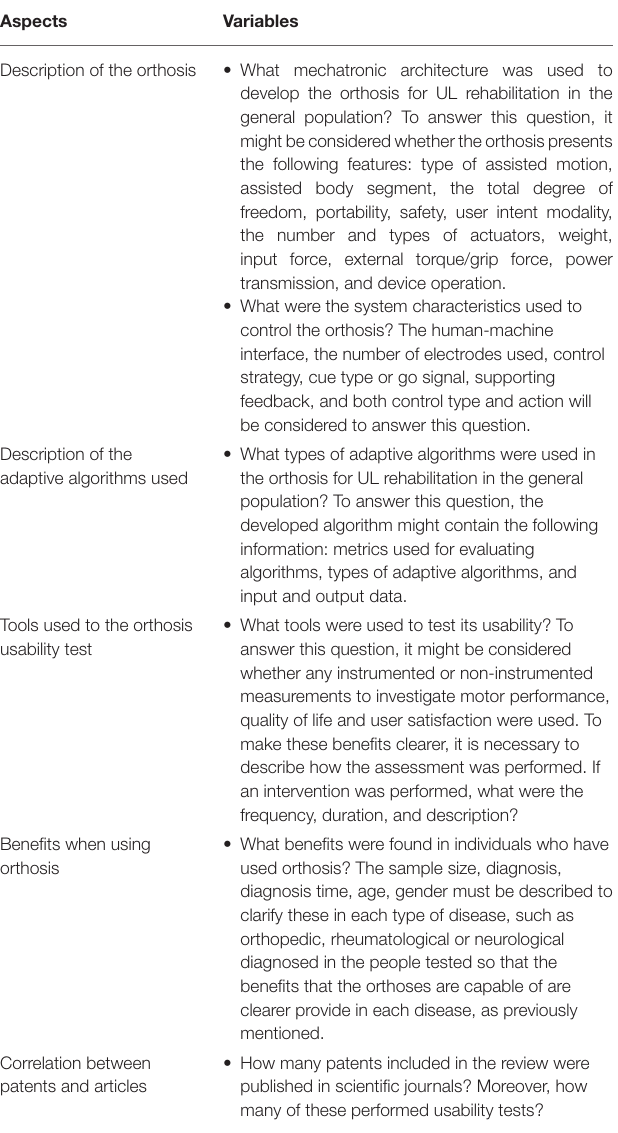
TABLE 3 | List of variables to be studied for each aspect.